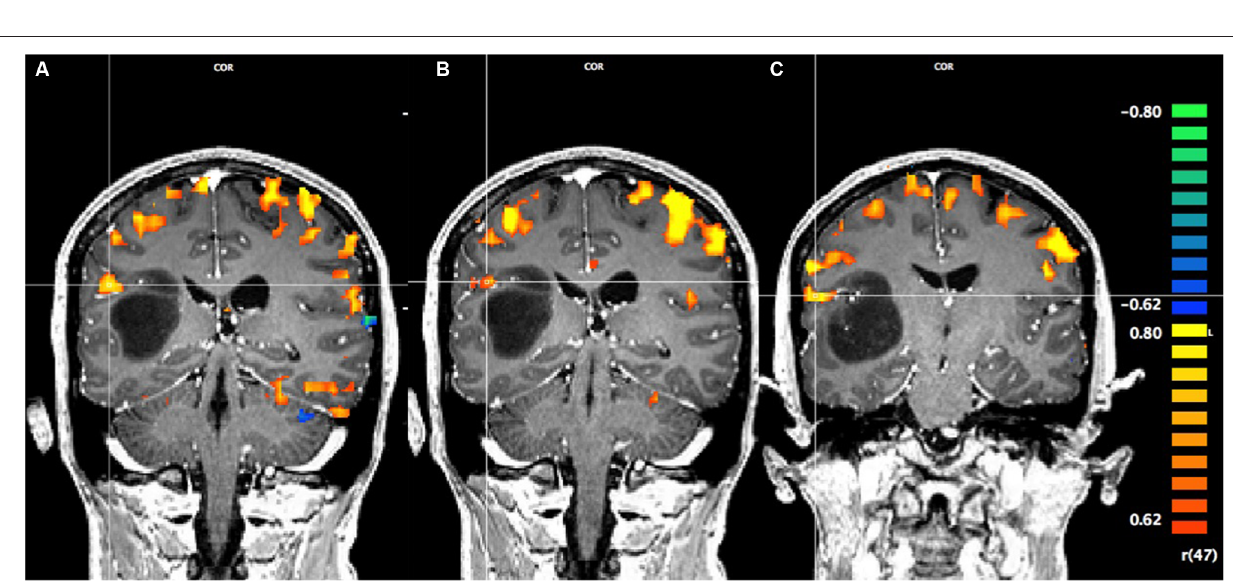
FIGURE 2 | Pre-operative Talaraich fMRI of the motor and sensory activation, whereby the position of the cross-hairs illustrates the activation of interest nearest to the astrocytoma in each task and the clusters described by the coordinates. (A) Activation in the arms rubbing on scanner task (coordinates: x = 51.7, y = − 28.8, z = 23.1; cluster size: 411 voxels). (B) Activation in the hands rubbing on scanner task (coordinates: x = 48.6, y = − 29.2, z = 23.6; cluster size: 53 voxels). (C) Activation in the lip-licking task (coordinates: x = 60.5, y = − 13.5, z = 16.9; cluster size: 185